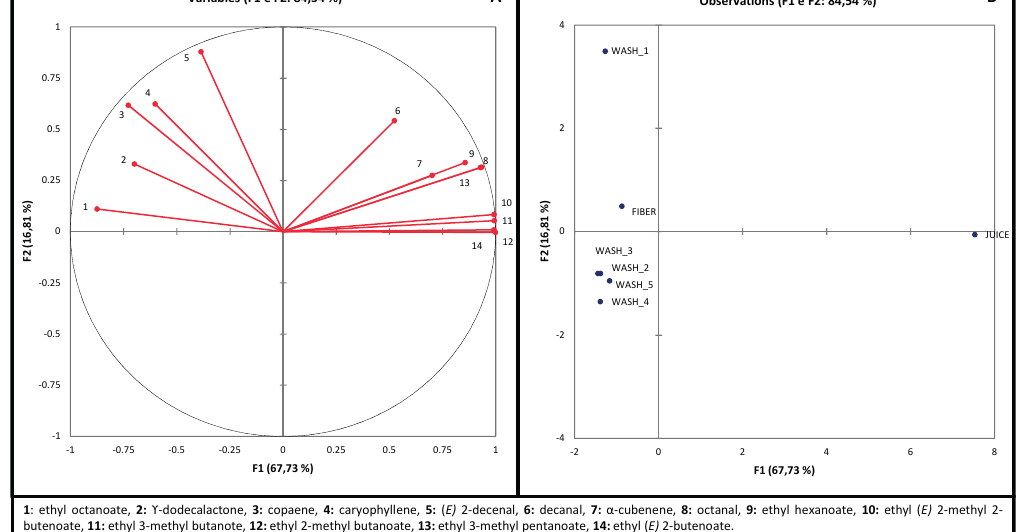
Figure 2. Principal Component Analysis of headspace odoriferous volatile compounds of cashew juice and co-products. ( A ) variables chart (volatile compounds); ( B ) observations chart (samples).